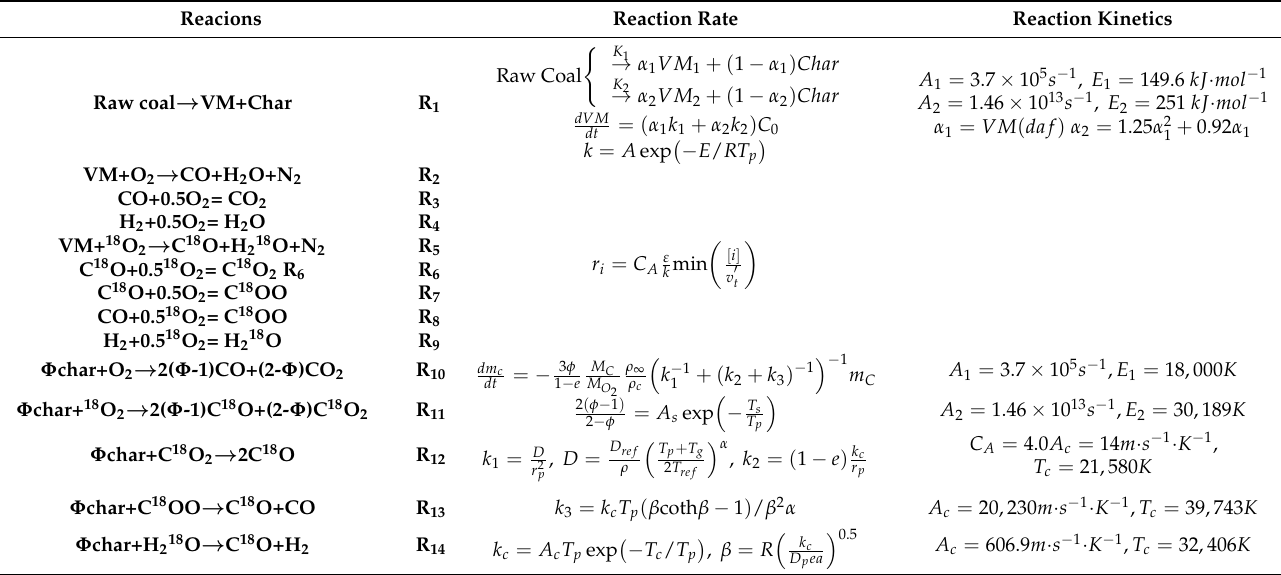
Table 4. Chemical reactions of coal and reaction kinetics